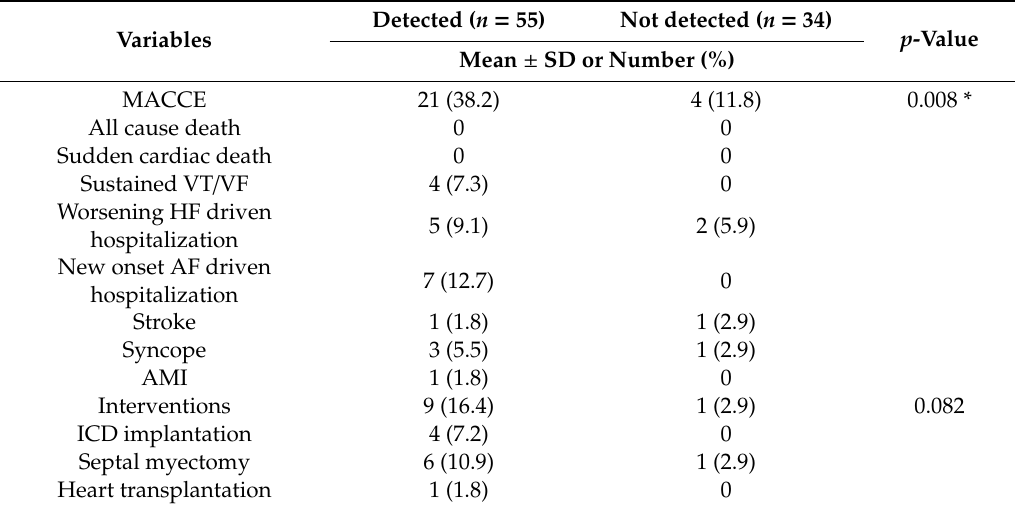
Table 5. Major adverse cardiac and cerebrovascular events and interventions during follow-up.